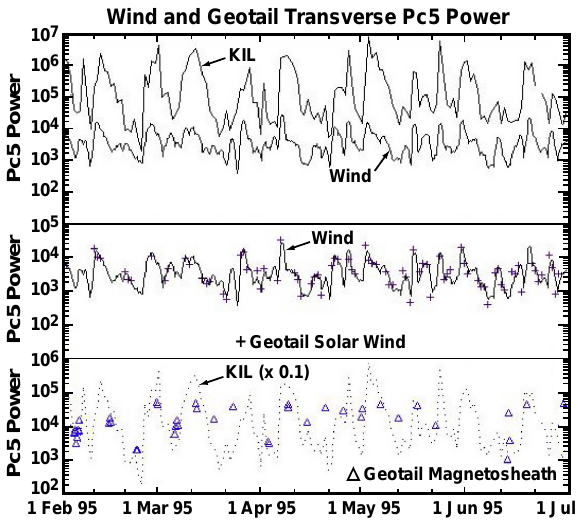
Fig. 3. Top panel: Pc5 pulsation power at Kilpisjarvi ground-based station (upper curve) compared to perpendicular Pc5 power at Wind (lower curve). Middle panel: perpendicular Pc5 power at Wind (curve) and Geotail (crosses) with both in the solar wind. Bottom panel: Pc5 pulsation power at Kilpisjarvi (dotted curve) and per- pendicular Pc5 power at Geotail in the magnetosheath